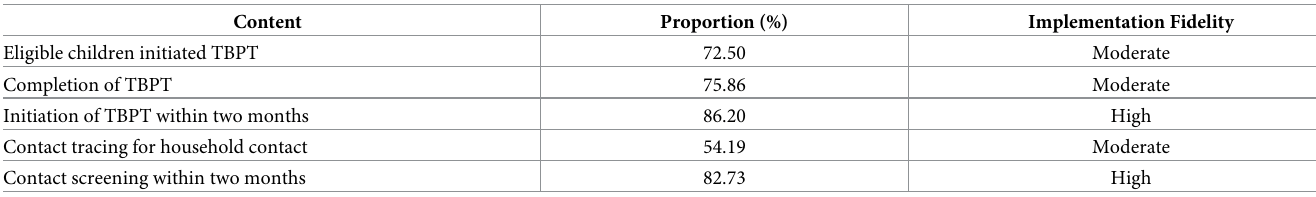
Table 2. Implementation fidelity of quantitative